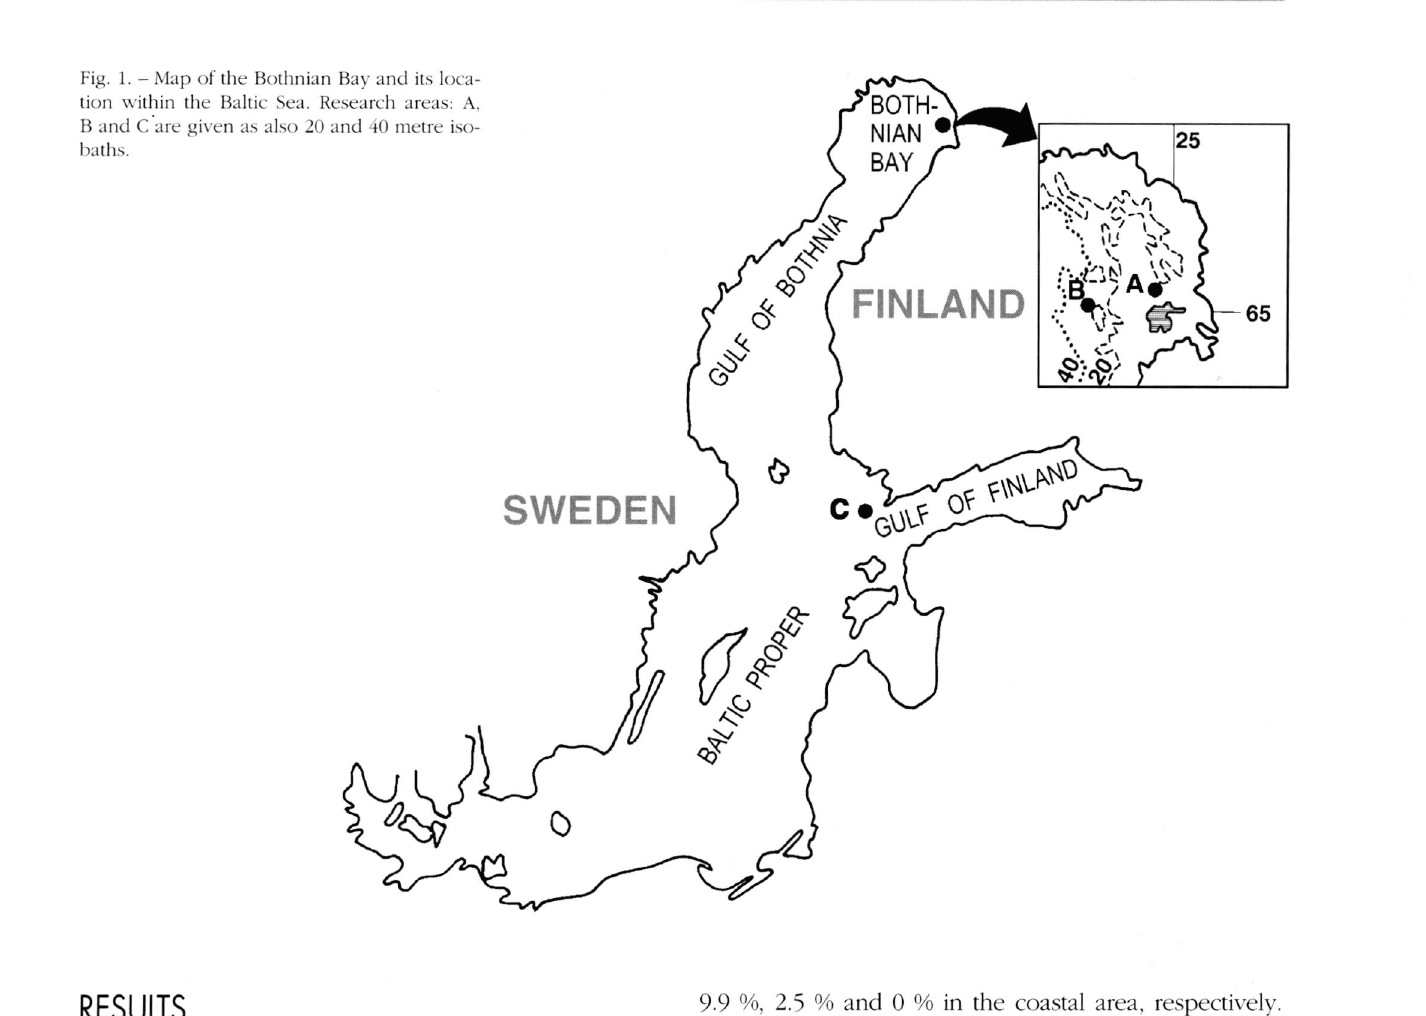
Fig. 1. - Map of the Bothnian Bay and its loca­ tion within the Baltic Sea. Research areas: A, B and C are given as also 20 and 40 metre iso­